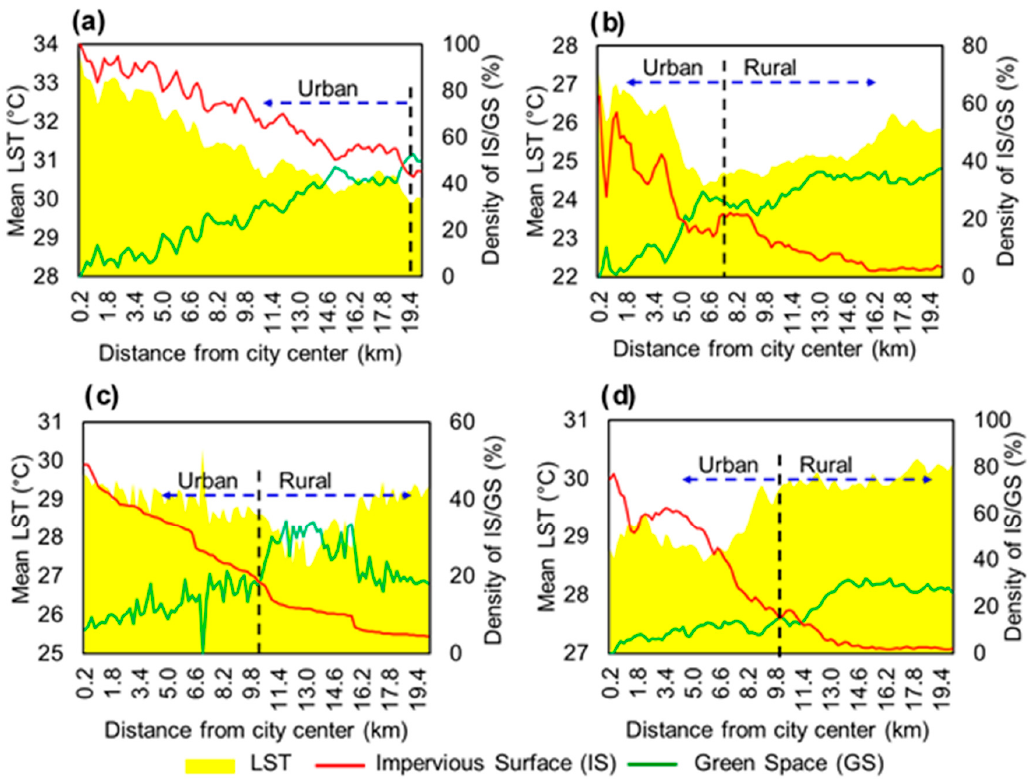
Figure 6. Relationships between the LST and impervious surfaces and green spaces along the urban–rural gradients of Lagos ( a ), Nairobi ( b ), Addis Ababa ( c ) and Lusaka ( d ). Note: Urban and rural were discerned based on the physical extent of the built-up footprint for each city.